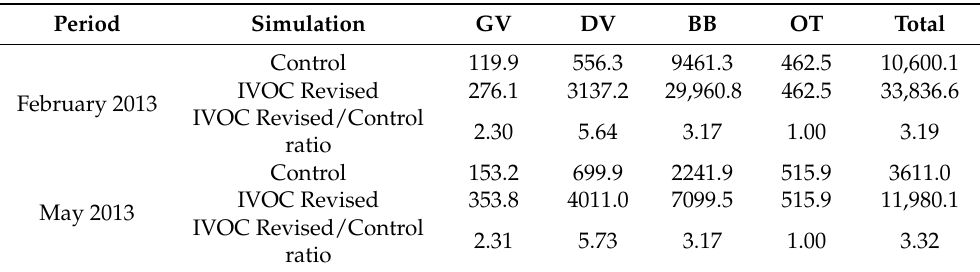
Table 2. Total VOC emissions (10 3 kg month − 1 ) over the Po Valley computational domain dur- ing February and May 2013, and contributions of each emissions sector (GV: gasoline vehicles; DV: diesel vehicles; BB: biomass burning; and OT: other sources). Control refers to the total